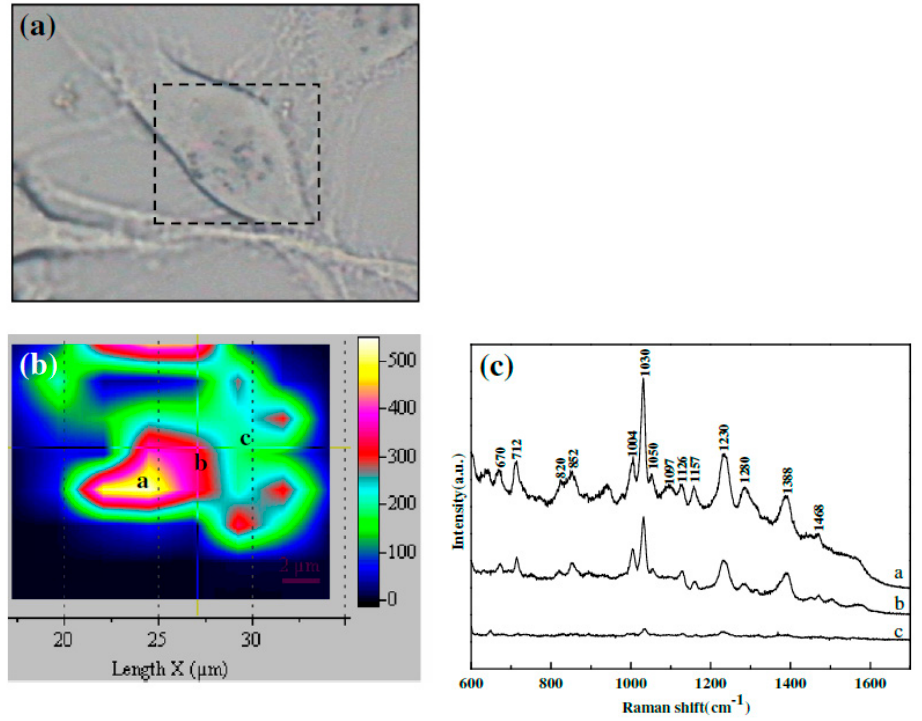
Figure 51. Photomicrograph of a fixed breast cancer cell ( a ) and SERS mapping image ( b ), obtained by recording the Raman signal at 1030 cm − 1 in the rectangle region, with 10 × 10 µ m 2 dimension (outlined in micrograph ( a )). The Raman signal at 1030 cm − 1 corresponds to the C–H in-plane bending mode of phenylalanine. SERS spectra recorded in position ( a – c ) of the labelled area ( c ). Reproduced with permission from Zhu et al. [456] under Creative Commons 2.0 license (https://creativecommons.org/licenses/by/2.0/).